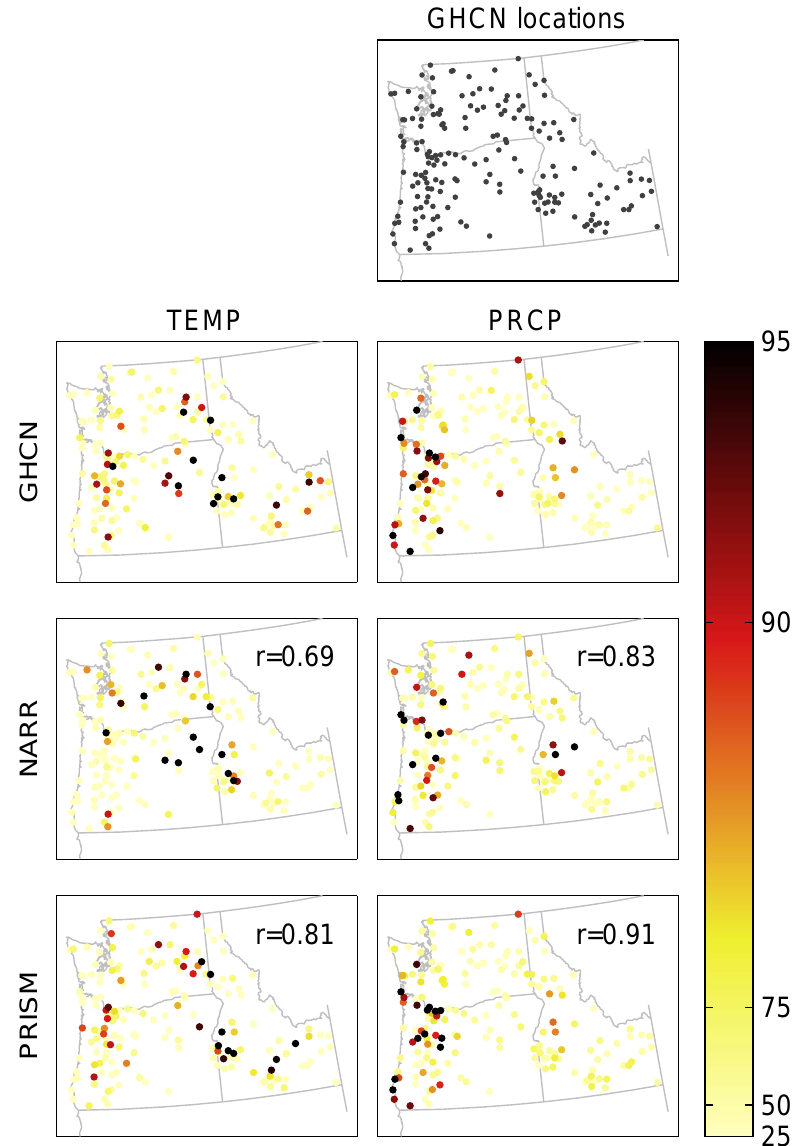
Fig. 3. Results from three different datasets (GHCN, NARR, PRISM), calculated for the 181 GHCN stations with continuous records for the period 1979–2011. The top map, labeled “GHCN locations”, shows the location of the GHCN stations used in the calculation. The 6 other maps show results for the different datasets. Each dot denotes the location of a GHCN station, and is shaded according to the percentage of time the station was chosen using the network design algorithm. Rank correlations with the GHCN results are shown in the top right corner of the NARR and PRISM maps. As with Fig. 2, percentile values are plotted to simplify interpretation. Note that, unlike in other figures, the color scale remains a light yellow at low values, and does not fade to